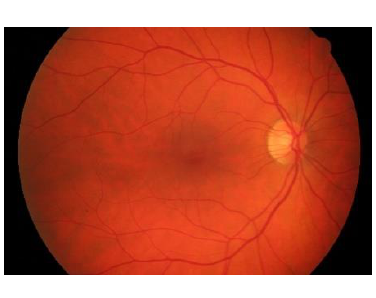
Figure 6.a. Input image